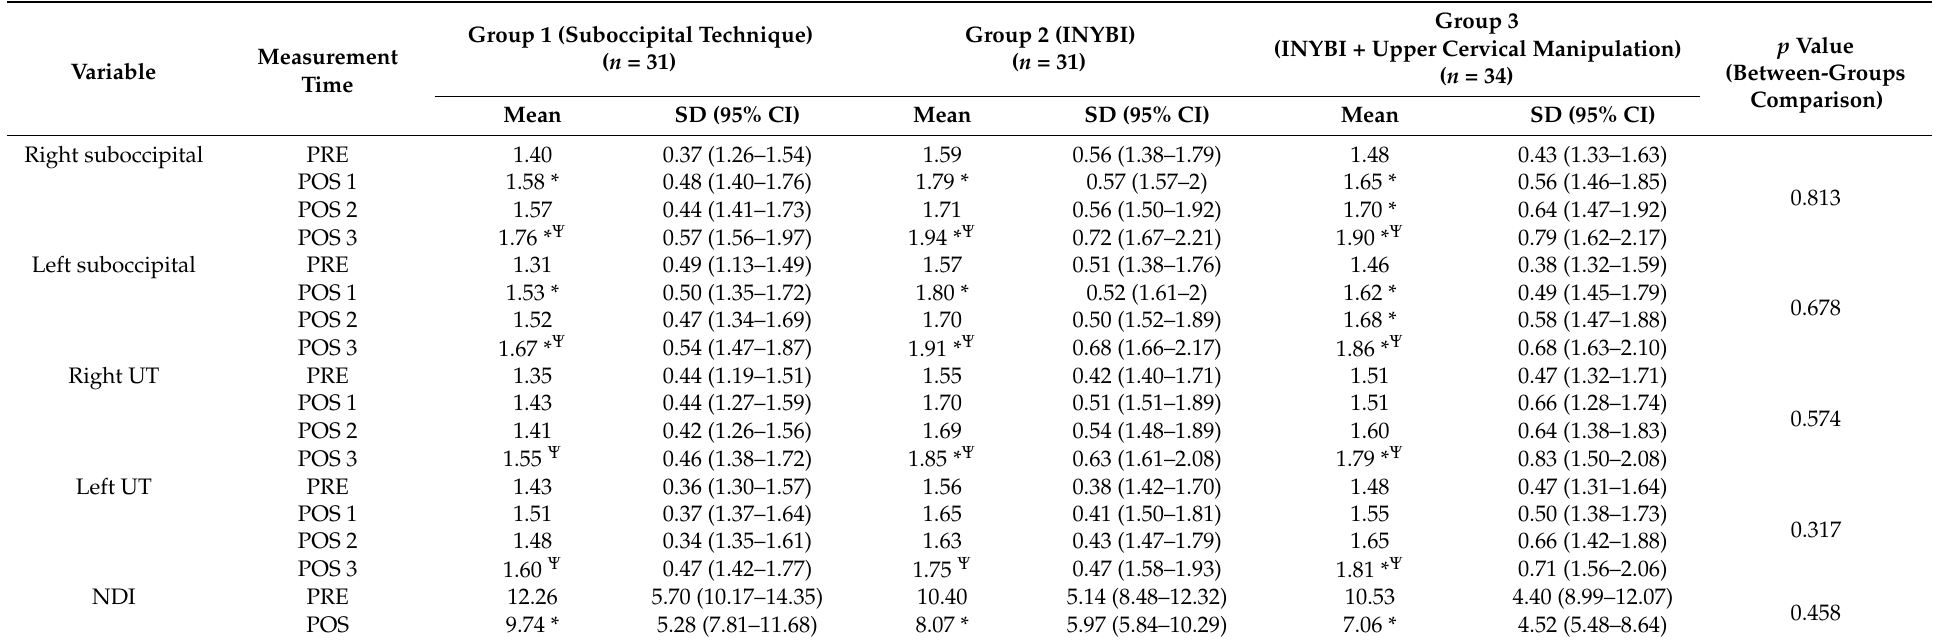
Table 4. PRE and POST Algometry and NDI